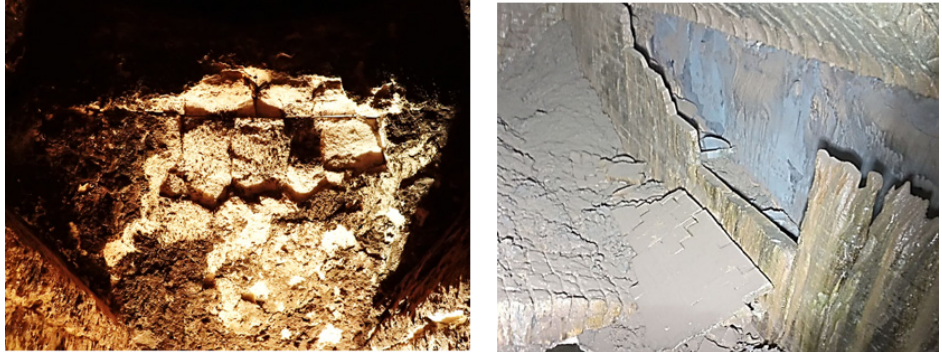
Figure 1. Decomposition of corroded biomass boiler lining.